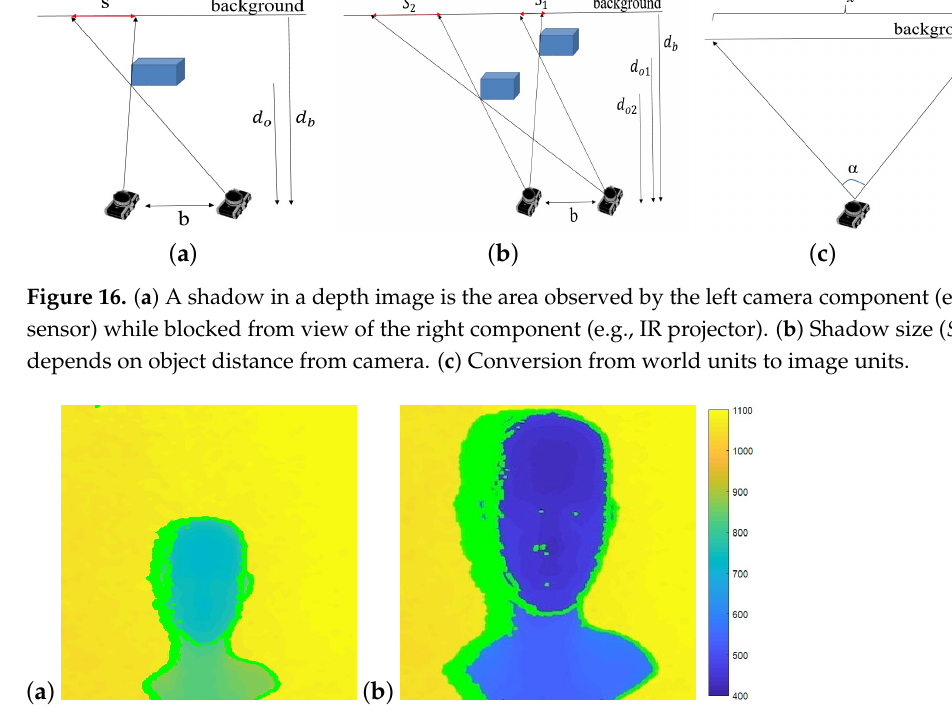
Figure 17. In both images, the distance from camera to the background is 1150 mm. The distance from camera to object is ( a ) 770 mm and ( b ) 450 mm. Shadow pixels are marked in green on the left side of the head. The smaller the distance from object to camera, the wider the shadow.